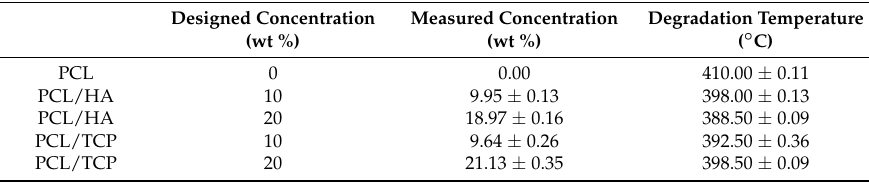
Figure 2. Thermal Gravimetric Analysis (TGA) curves ( a ) and derivative thermogravimetric (DTG) curves ( b ) for all scaffolds. Table 2. Concentration of HA and TCP on the composite